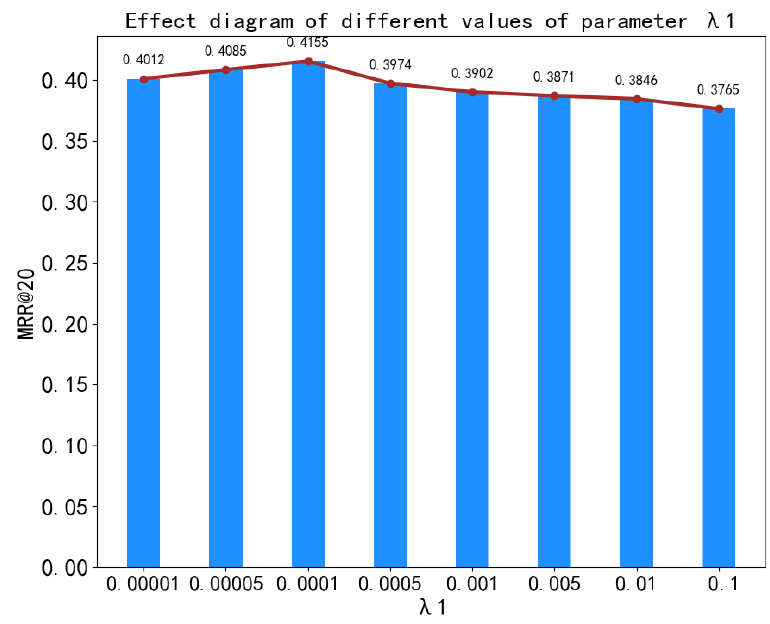
Figure 11. Effect diagram of different values of parameter λ 1